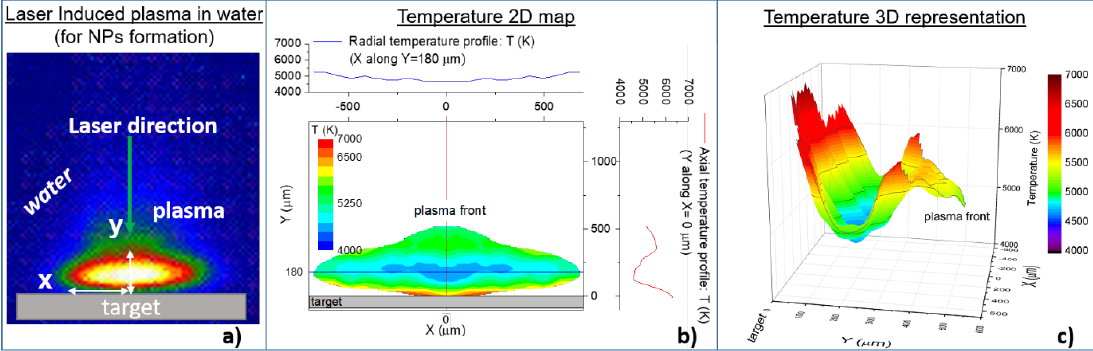
Figure 3. ( a ) Image of laser-induced plasma on Al target immersed in water, acquired with ICCD camera. ( b ) Plasma temperature 2D map calculated as reported in [43] (Al target in MilliQ water, E laser = 270 mJ, laser crater size = 1 ± 0.2 mm, λ laser = 532 nm, laser pulse duration = 6 ns, laser frequency = 10 Hz, delay time = 40 ns, gate width = 20 ns). ( c ) 3D representation of plasma temperature in ( b ).